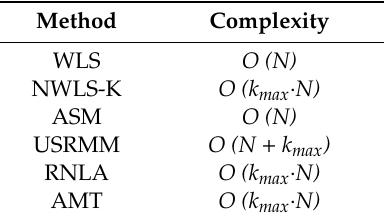
Table 1. Complexity analysis of the considered